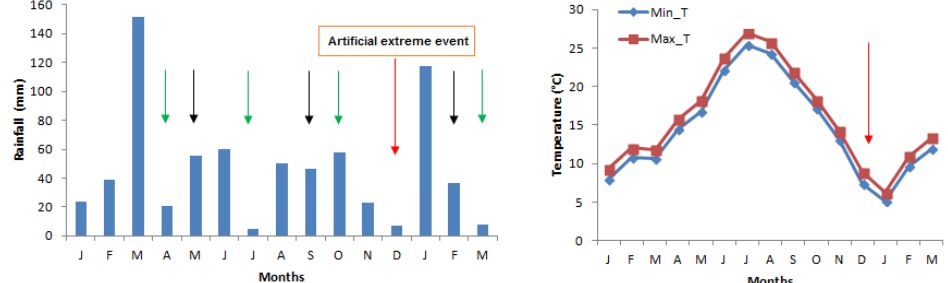
Figure 3. Mean monthly temperature and cumulative rainfall at the study site in the trial period (January 2016 and March 2017). The arrows indicate the date of the survey carried out in the FS (green arrows) and in the R (black arrows). The red arrow indicates the month of the extreme rainfall event.